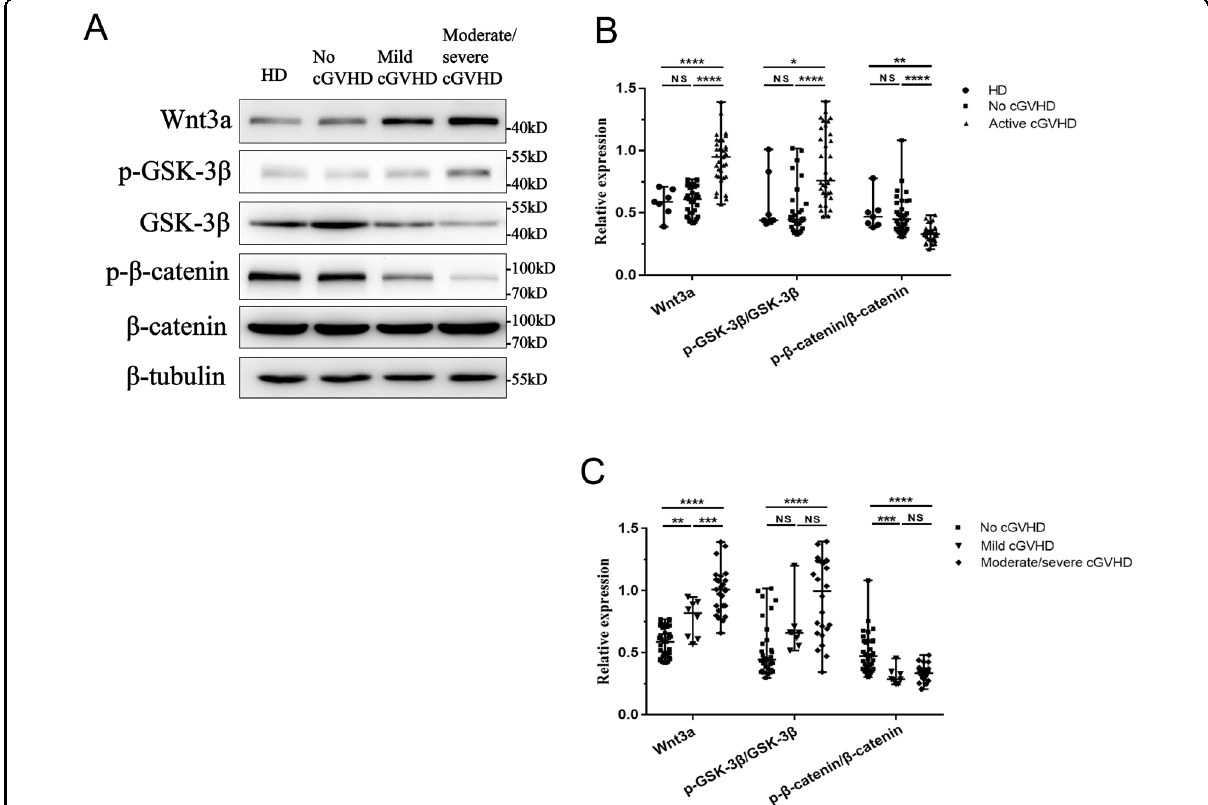
Fig. 4 Upregulation of the Wnt/ β -catenin pathway in MSCs from patients with active cGVHD. A Representative protein expression of Wnt3a, phosphor-GSK-3 β , total-GSK-3 β , phosphor- β -catenin, total- β -catenin, and β -tubulin in MSCs derived from healthy donors, patients without cGVHD, patients with mild-cGVHD and patients with moderate/severe cGVHD. B Relative protein expression of HD-MSCs, no cGVHD-MSCs, and active cGVHD-MSCs. C Relative protein expression of MSCs with different severities of cGVHD.Protein expression was normalized within each sample to the internal reference protein β -tubulin. HD-MSCs ( n = 7), no cGVHD-MSCs ( n = 33), mild cGVHD-MSCs ( n = 8), and moderate/severe cGVHD-MSCs ( n = 25). Black bars in each fi gure represent the median ± range. NS, not signi fi cant. * P < 0.05, ** P < 0.01, *** P < 0.001, and **** P <